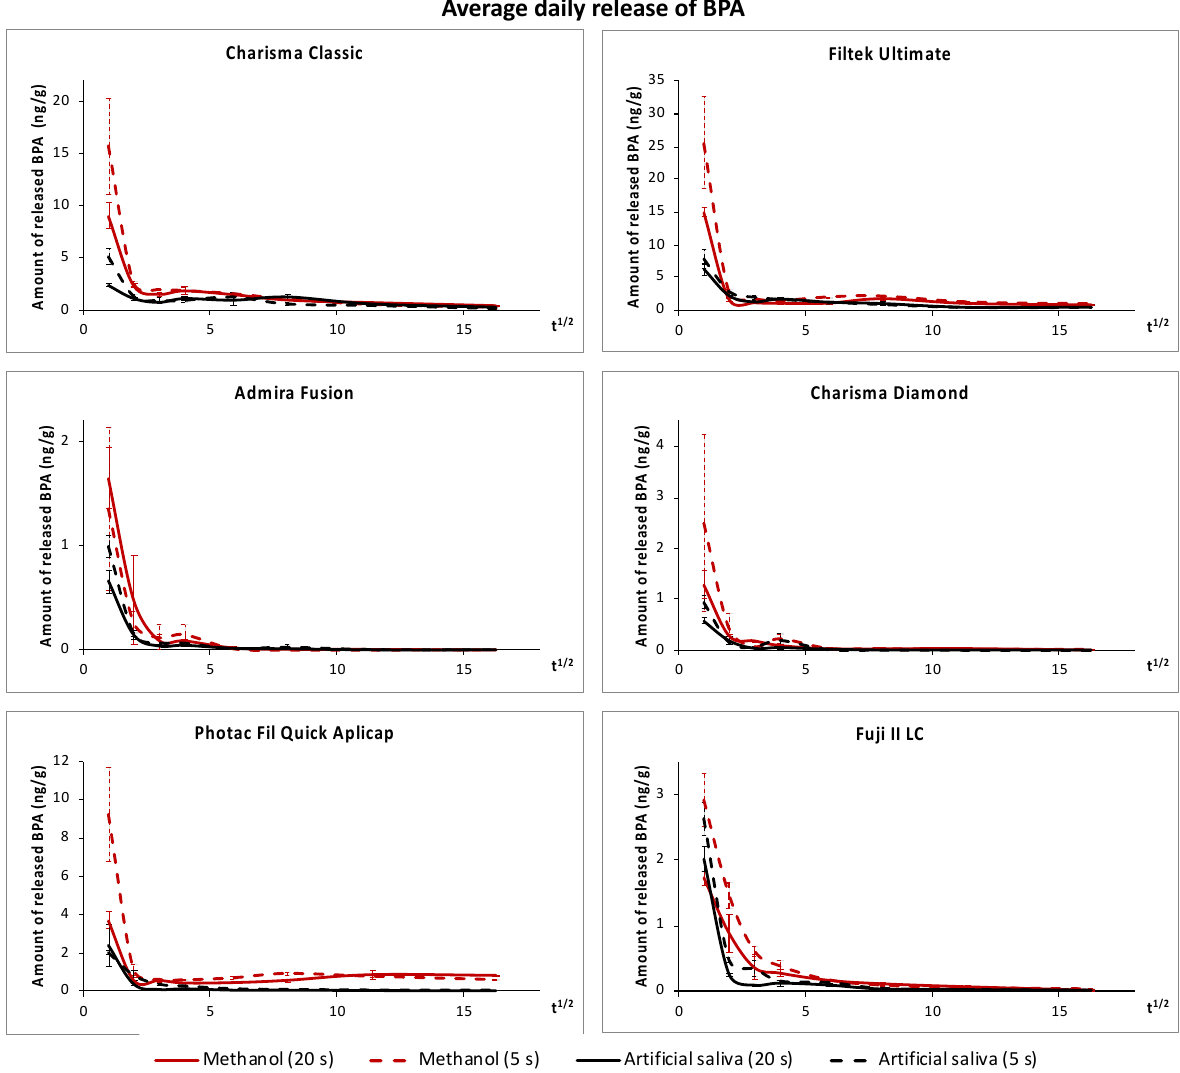
Figure 1. Average daily release of BPA in the artificial saliva ( black ) and methanol ( red ) plotted against the square root of time. The solid lines represent standard polymerization (20 s, 1300 mW/cm 2 ), whereas dashed lines represent fast polymerization (5 s, 3000 mW/cm 2 ).